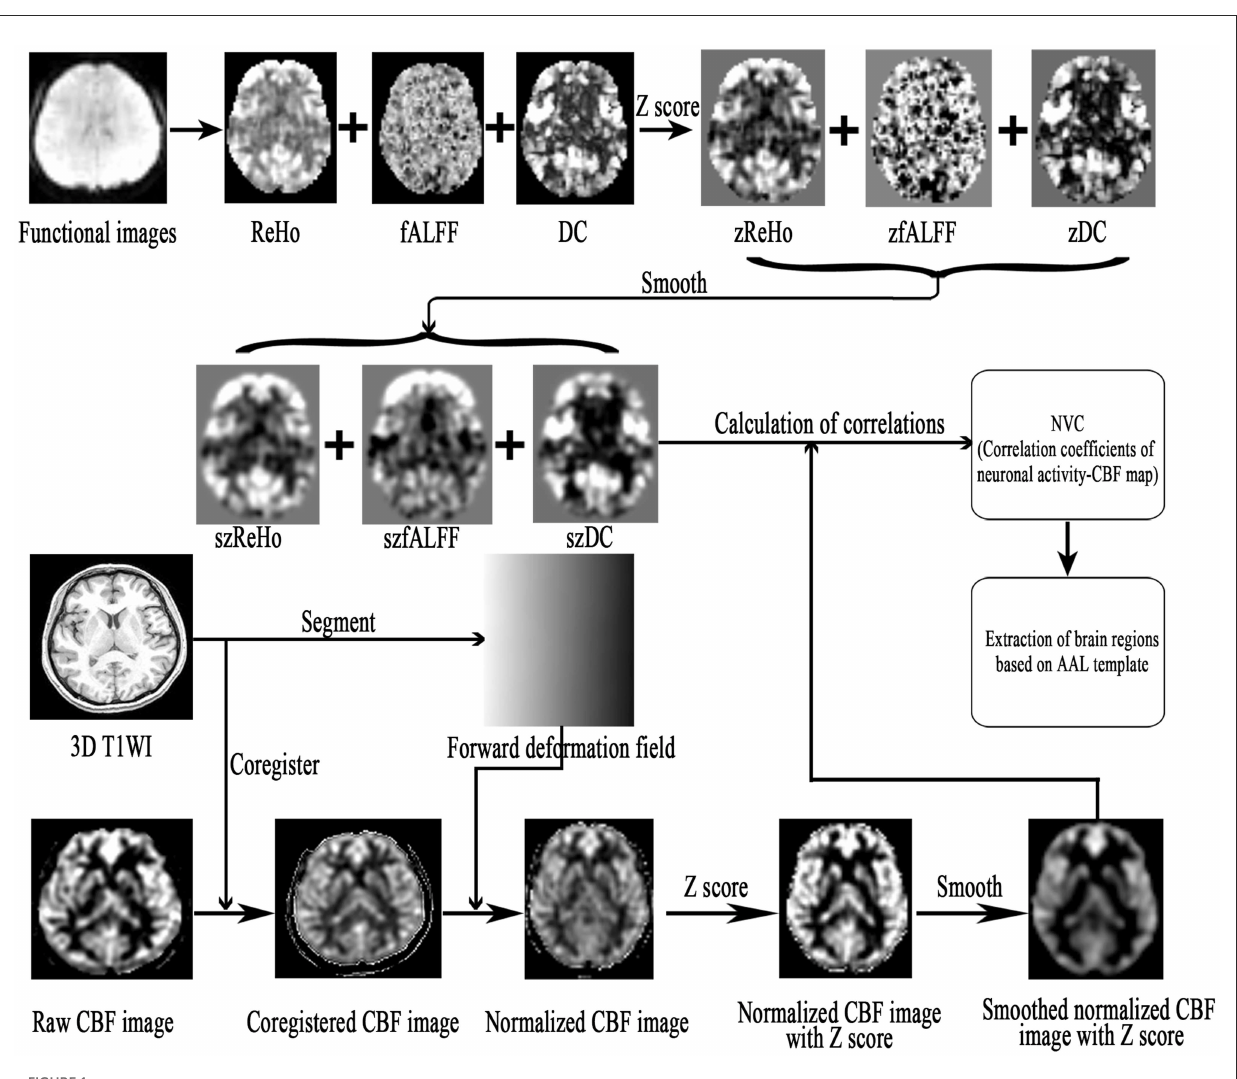
FIGURE1 . A flowchart outlining the analysis of neurovascular coupling (NVC) in the